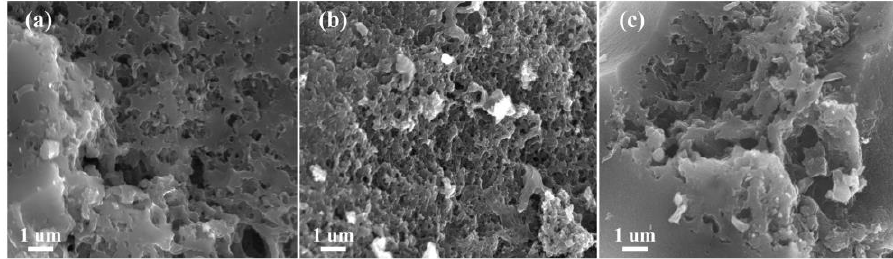
Figure 4. SEM images of samples, ( a ) C OCLP-3.5 ; ( b ) C OCLP-4.5 ; ( c ) C OCLP-5.0 .